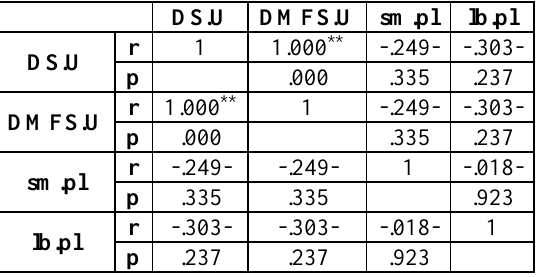
Table 8: Pearson correlation for upper permanent teeth with streptococcus and lacto bacillus bacteria in